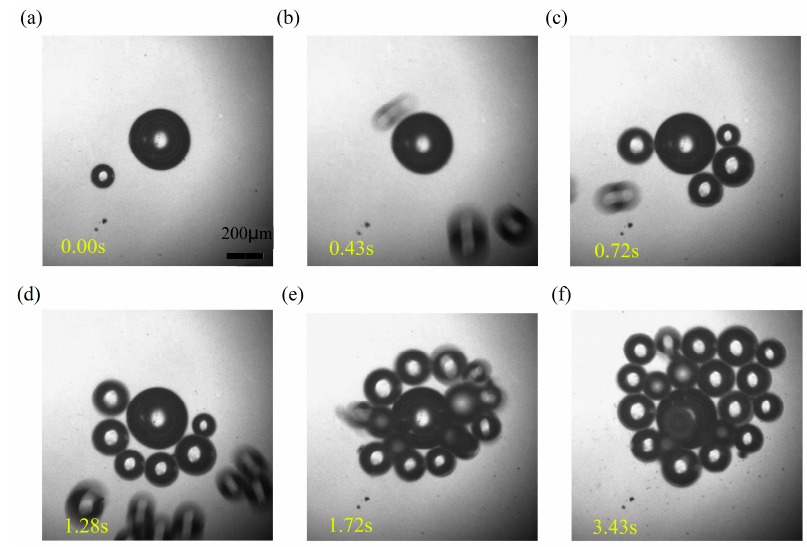
Figure 6. Collection process of microparticles by a bubble; the time format unit is seconds. The frequency and voltage of piezo-actuator is 8 kHz and 30 V; the diameter of bubble and micro glass balls is about 150 μ m and 50–100 μ m. ( a ) 0.00 s, ( b ) 0.43 s, ( c ) 0.72 s, ( d ) 1.28 s, ( e ) 1.72 s and ( f ) 3.43 s.